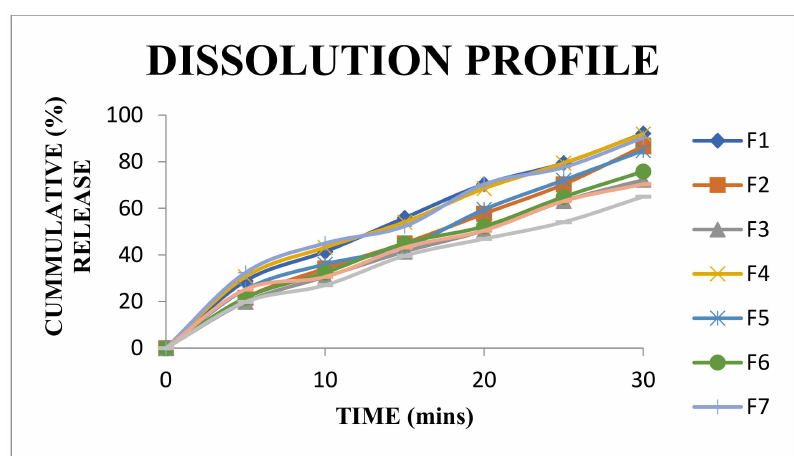
Figure 10. Comparative dissolution profiles for formulations F1 to